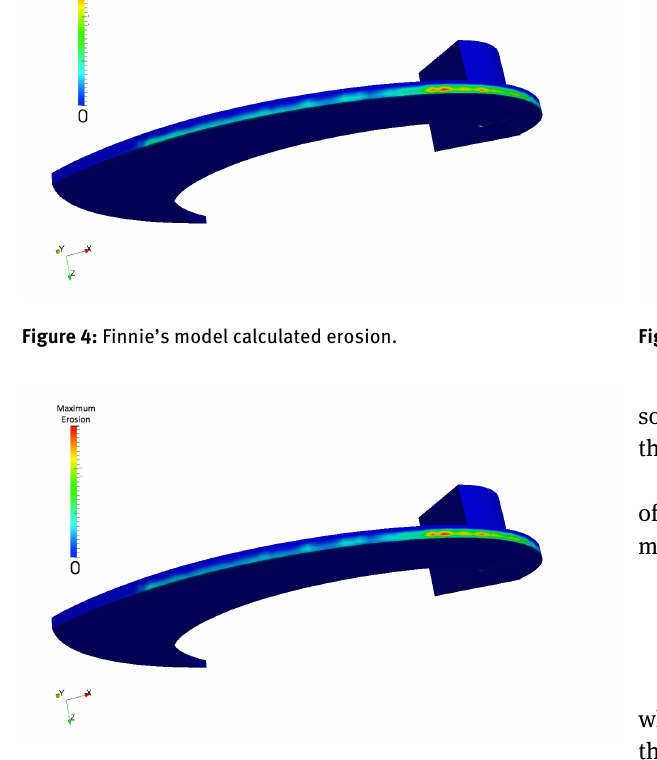
Figure 5: Grant and Tabakoff’s model calculated erosion.